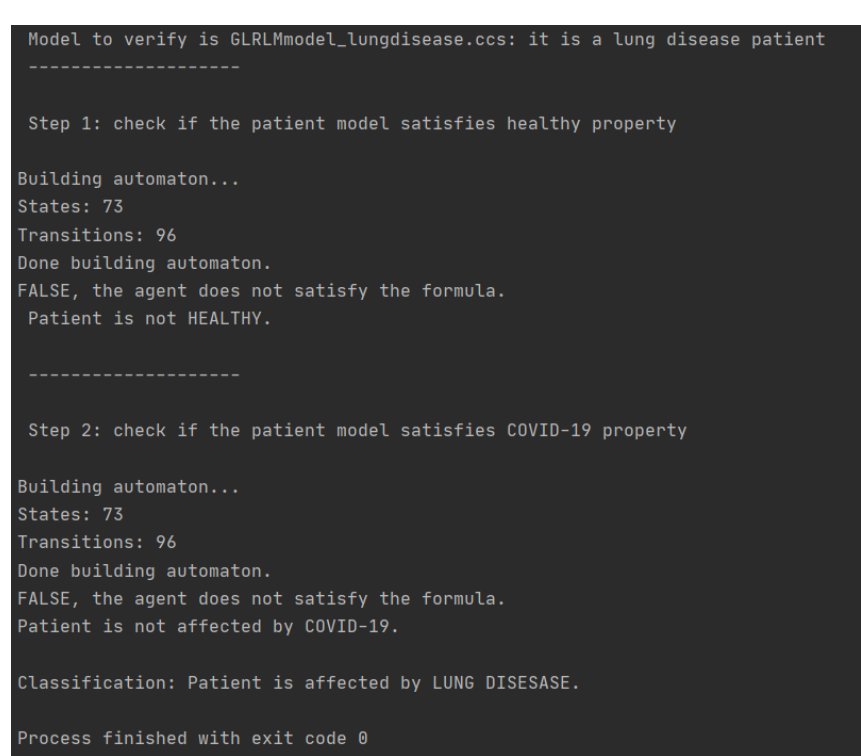
Figure 8. This Figure represents the execution of a diagnosis. The program starts by inputting a formal model (in this case, a lung disease model), and the property of the healthy state because we are in the first step. The result is “FALSE”, so Model checking verified that the patient is not healthy. The method will go on to the second step. Now, the program has as an input the same patient model with the COVID-19 property: the result is “FALSE”. In conclusion, the diagnosis is that the patient is affected by a lung